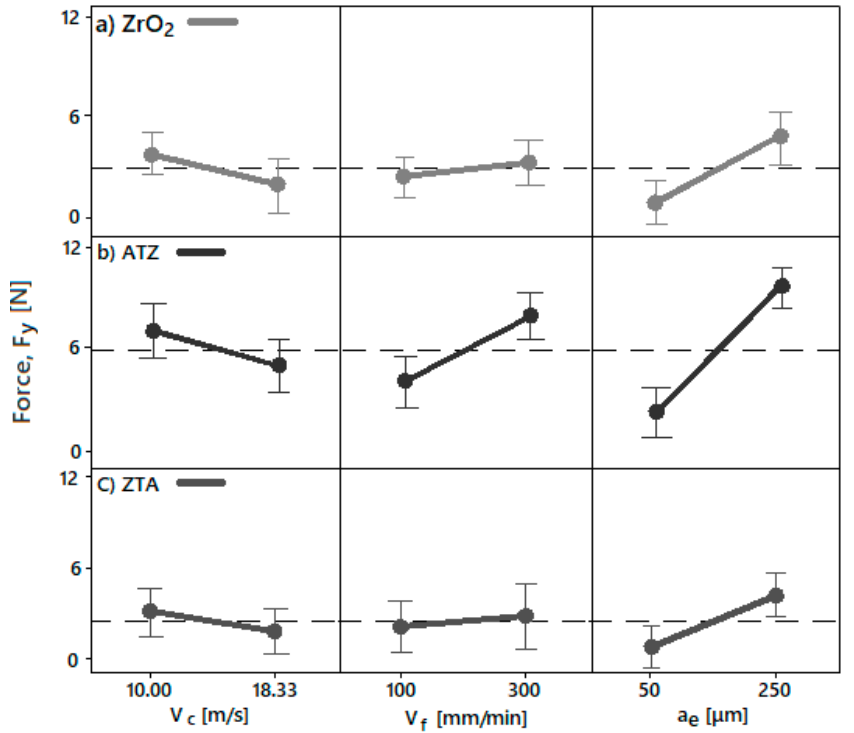
Figure 10. The main e ff ect diagram for forces (Fy) of ( a ) ZrO 2 , ( b ) ATZ, and ( c ) ZTA in regard to peripheral speed (v c ), feed rate (v f ), and depth of cut (a e ).